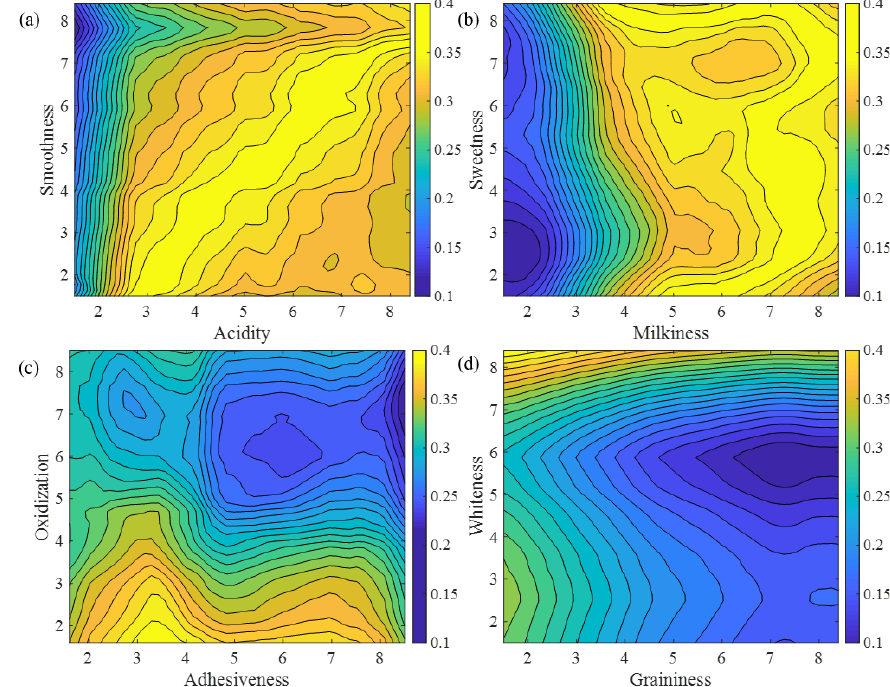
Figure 6. Hedonic contour mapping of a specific type of yogurt for the attributes combination of ( a ) acidity and smoothness, ( b ) milkiness and sweetness, ( c ) adhesiveness and oxidization, ( d ) graininess and